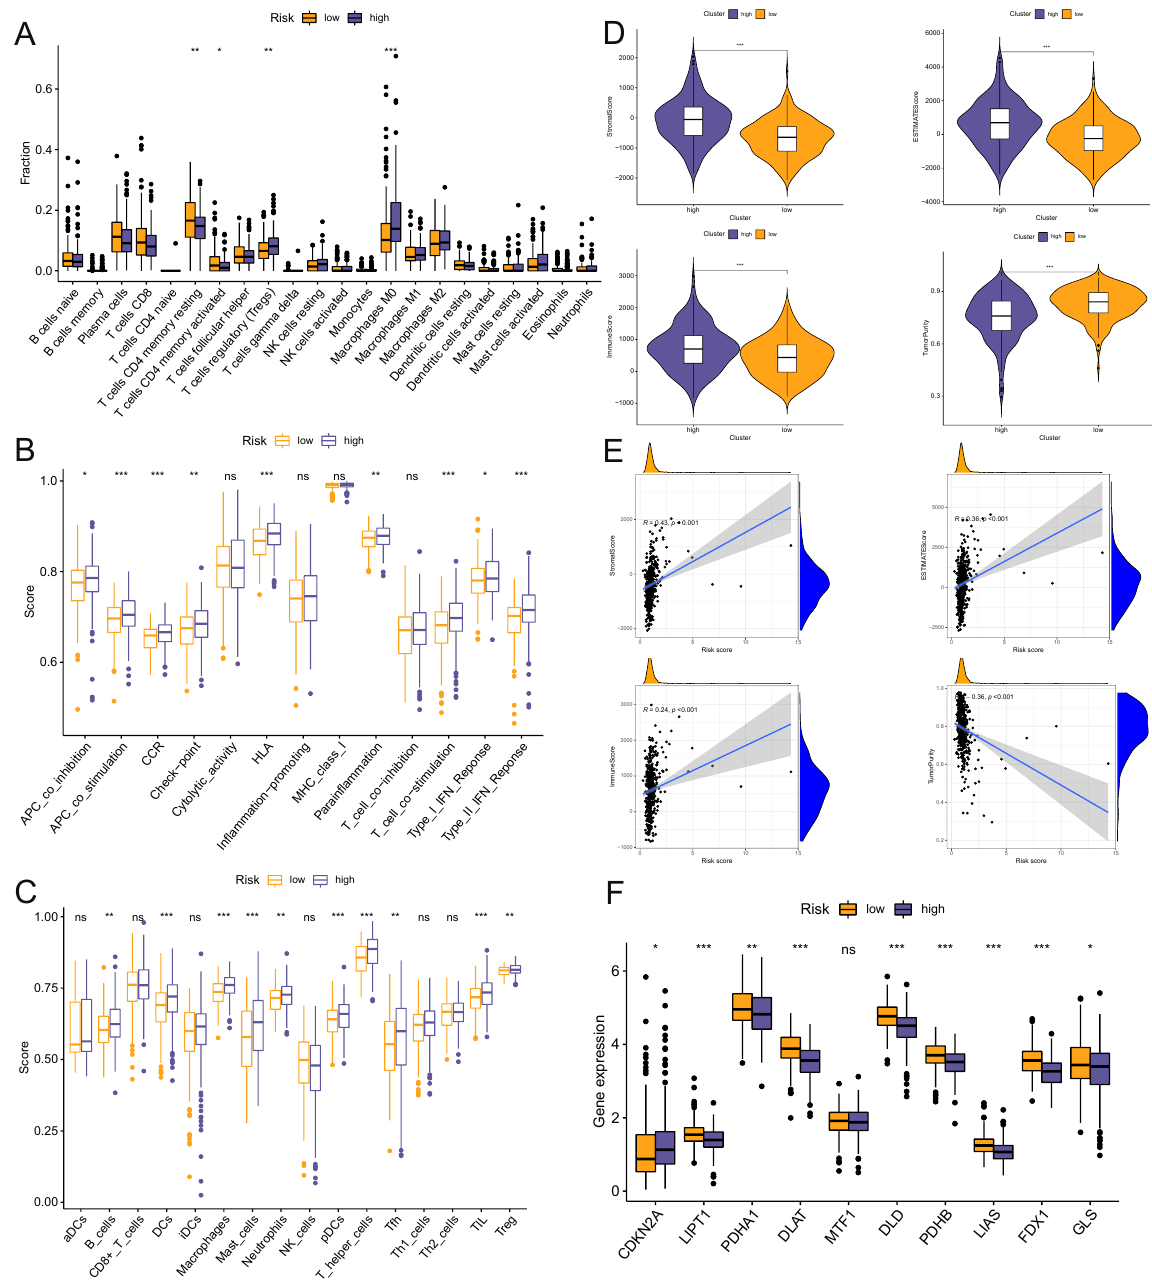
Figure 7. The high- and low-risk groups present different immune statuses. ( A ) The boxplots for the comparison of the 22 immune cells between the high-risk and low-risk groups in colon cancer. ( B , C ) Immune cells infiltration score ( B ) and immune-related pathways’ activity ( C ) in the high- and low-risk groups estimated by ssGSEA. ( D ) Expression level of the stromal score, ESTIMATE score, immune score, and tumor purity in the high- and low-risk groups. ( E ) Associations between the risk score and immune cell infiltration levels. ( F ) Cuproptosis-related genes between the high-